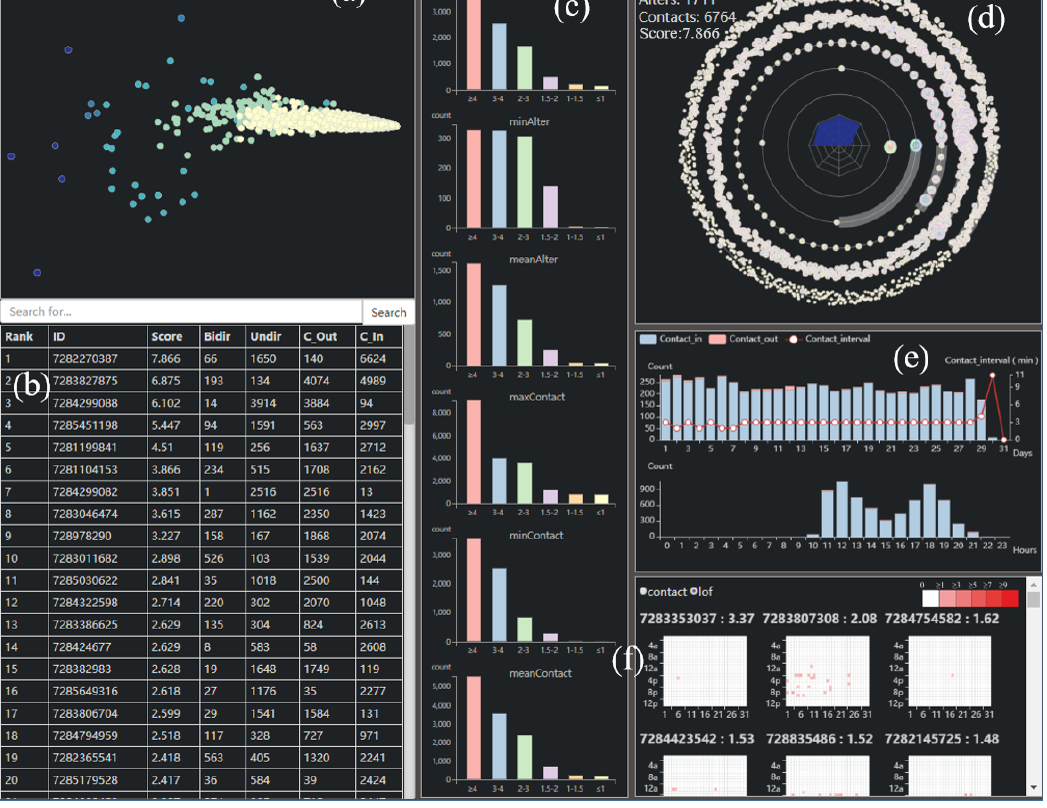
Figure 4. The overview of egoDetect based on the call record data. The user interface consists of six parts: ( a ) The distribution of users with their features, ( b ) a list sorted by users’ anomaly scores, ( c ) statistical information for each segment, ( d ) the ego network glyph inspired from solar system, ( e ) the statistical view of ego’s active time and behavior, ( f ) the detail view about the contact between the ego with each